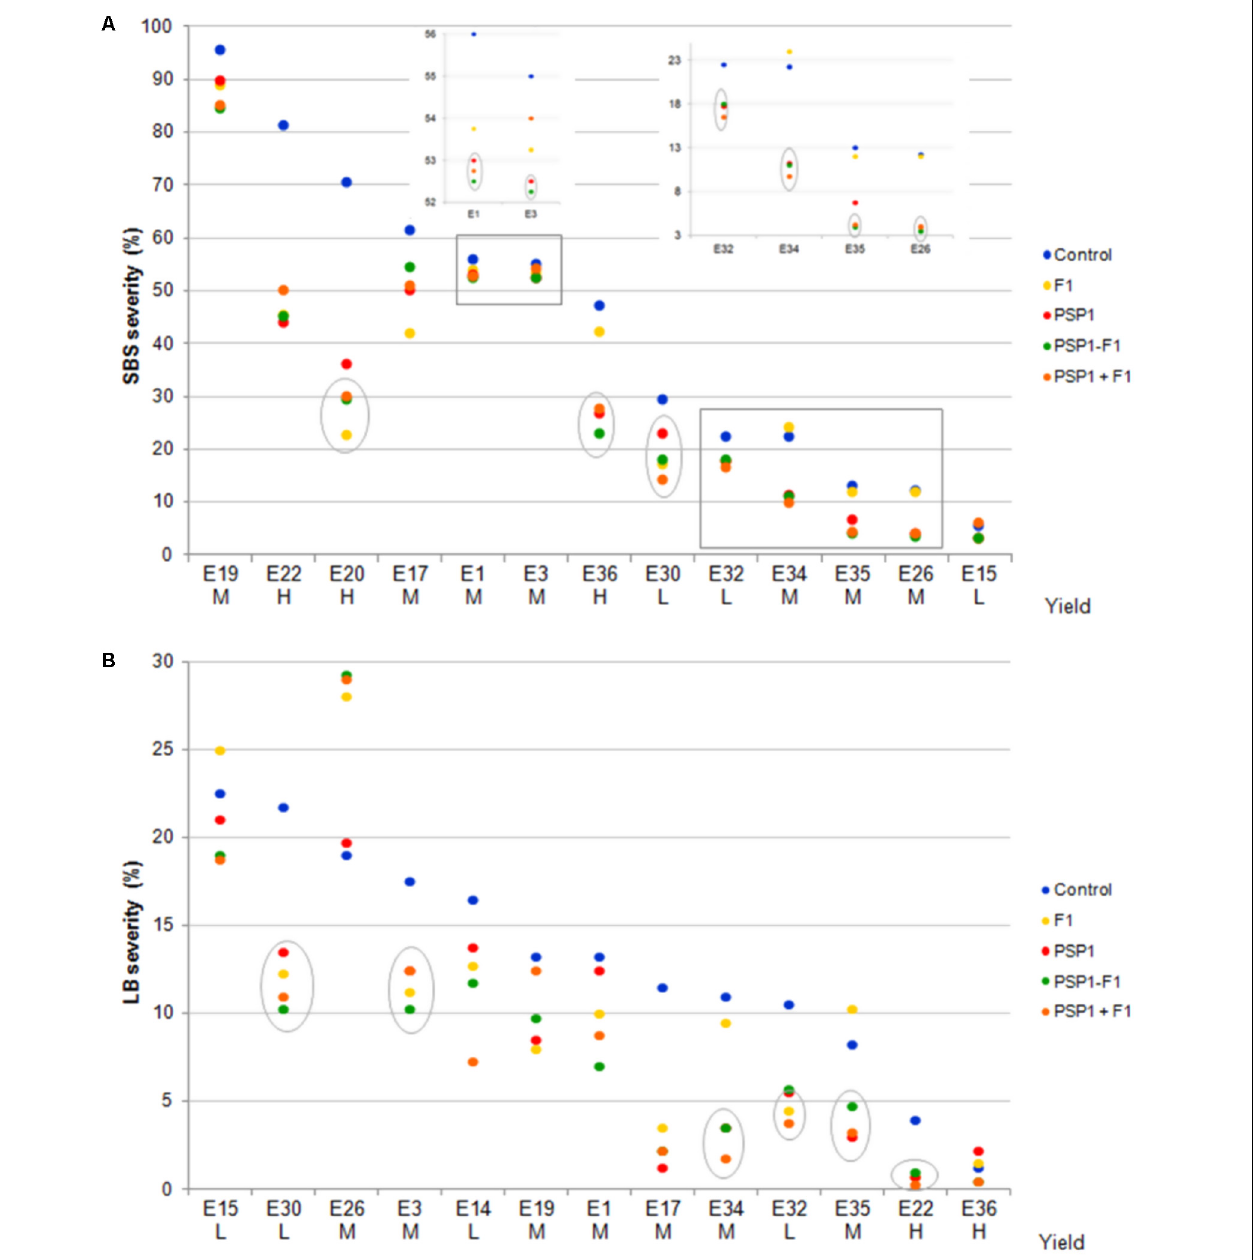
FIGURE 5 | Soybean field trials at 14 different locations in the central region of Argentina during growing season 2014-15. Severities (%) of SBS ( S. glycines ) and LB ( C. kikuchii ) assessed 40 days after R3 application are shown in (A,B) , respectively. Trials (named E) are ranked according to decreasing severity values in the control treatment for each disease and classified according grain yield in low (L), medium M and high yield (H). Treatments were control (standard soybean crop management without foliar fungicide or biocontrol treatment), F1 (fungicide F1 alone at R3), PSP1 (PSP1 alone at V6), PSP1-F1 (PSP1 at V6 plus fungicide F1 at R3 one at the time) and PSP1+F1 (PSP1 plus fungicide F1 at R3 at the same time). Symbols in gray circles indicate treatments significant different to the correspondent control treatment (according to Dunnet test; p < 0.05) and gray boxes are enlarged on the inserted graphics for better view. SBS or LB severity were not evaluated for E14 and E20, respectively. L, low yield; M, medium yield; H, high